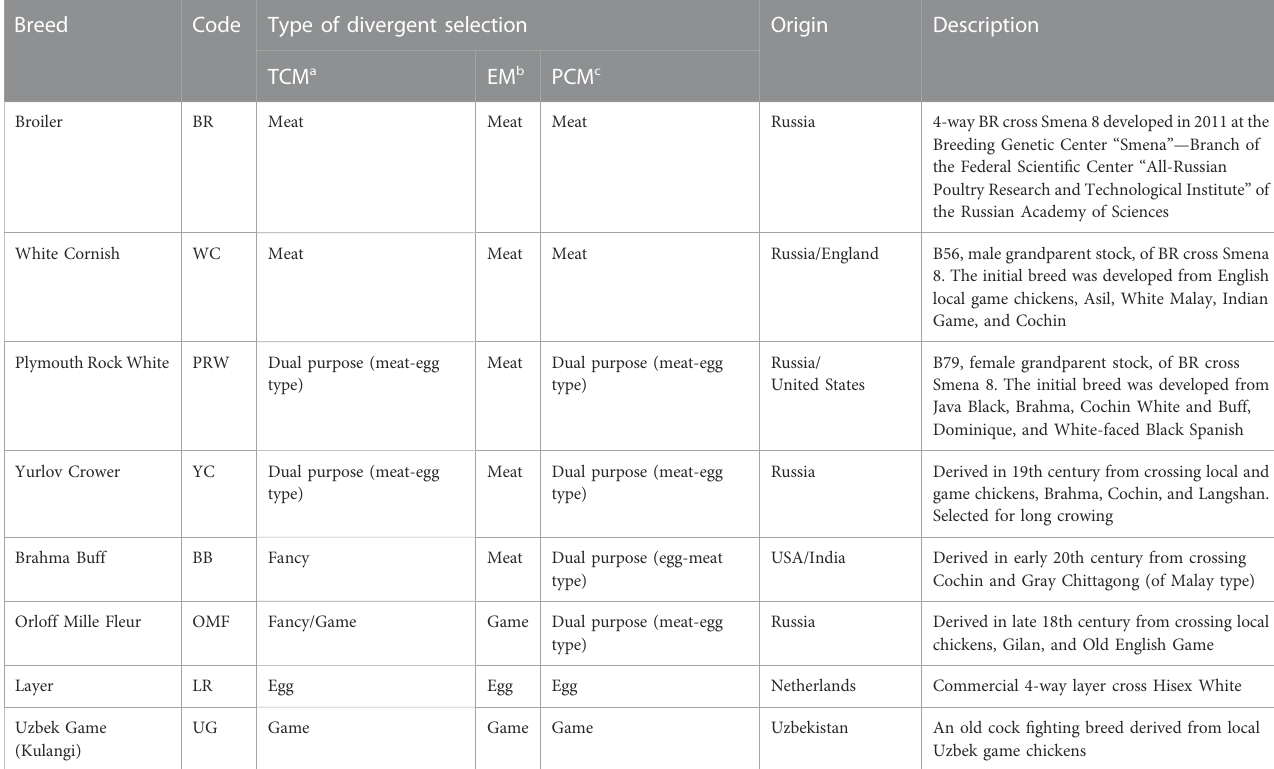
TABLE 1 Characterization of the studied chicken breeds.